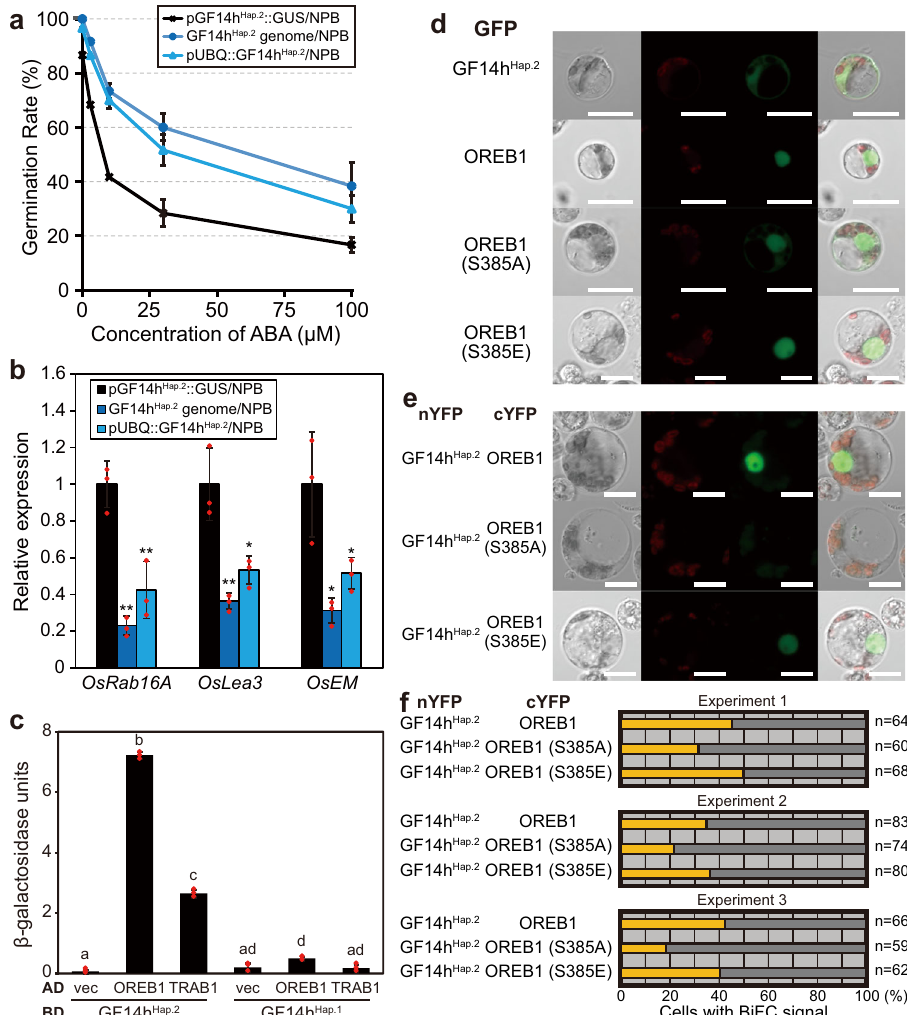
Fig.3|GF14hisinvolvedintheABAsignallingpathway.a ABAresponsivenessof the seed germinability of the GF14h complemented or control plants for 72h at 30°C. Error bars, s.d. ( n =3 biologically independent samples). b Relative tran- scription of ABA-responsive genes in seeds at 12h after imbibition at 30°C. Error bars, s.d. ( n =3 biologically independent samples). The relative expression in pGF14h Hap.2 ::GUS plants (left) was set as 1. ** P value<0.01, * P value<0.05 based on two-sidedstudent ’ s t test.Theexact P valueswereshowninSourceData fi le. c Yeast two hybrid system for the interaction of OREB1 or TRAB1 and GF14h haplotype [Hap.]1 or Hap.2 product. Letters indicate signi fi cant differences ( n =3 biologically independentsamples, P <0.01,Tukey ’ sHSDtest).Theexact P valueswereshownin